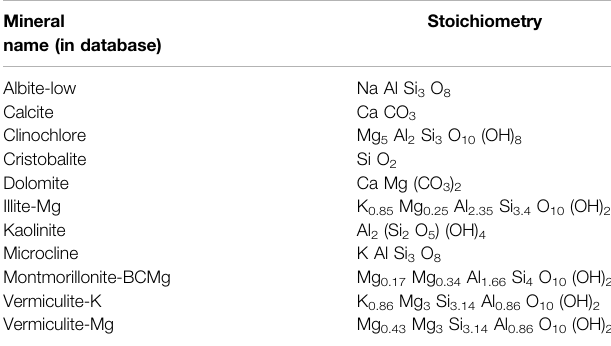
TABLE2| Listofmineralsandtheirstoichiometriccompositionsselectedfromthe sit.dat